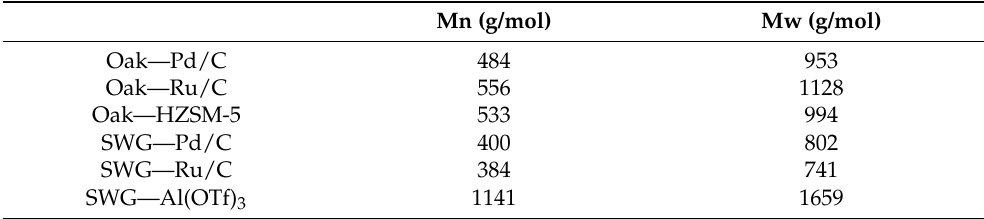
Table 3. The number average molecular weight (Mn) and weight average molecular weight (Mw) of phenolic oils produced via lignin-first fractionation/depolymerization experiments in ethanol/water at 210 ◦